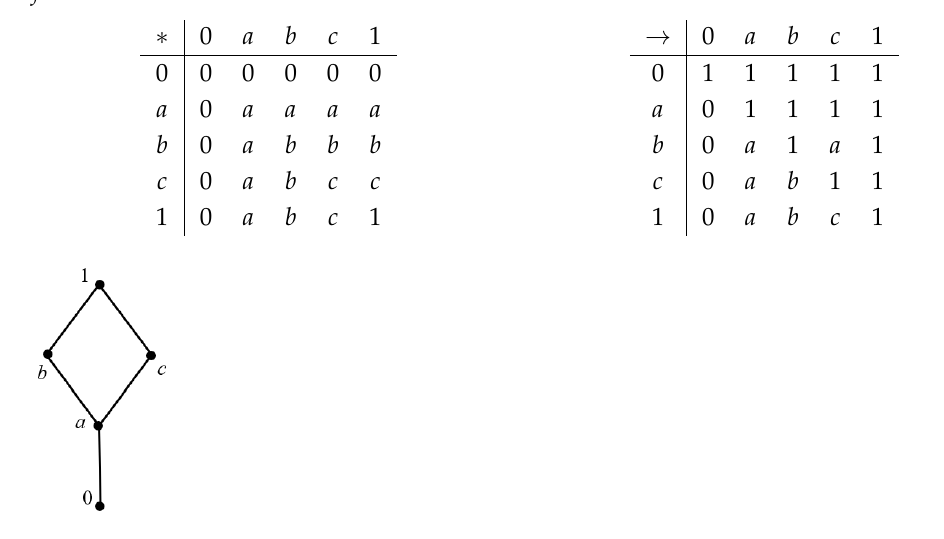
Figure 4. Lattice structure of (1) in Example